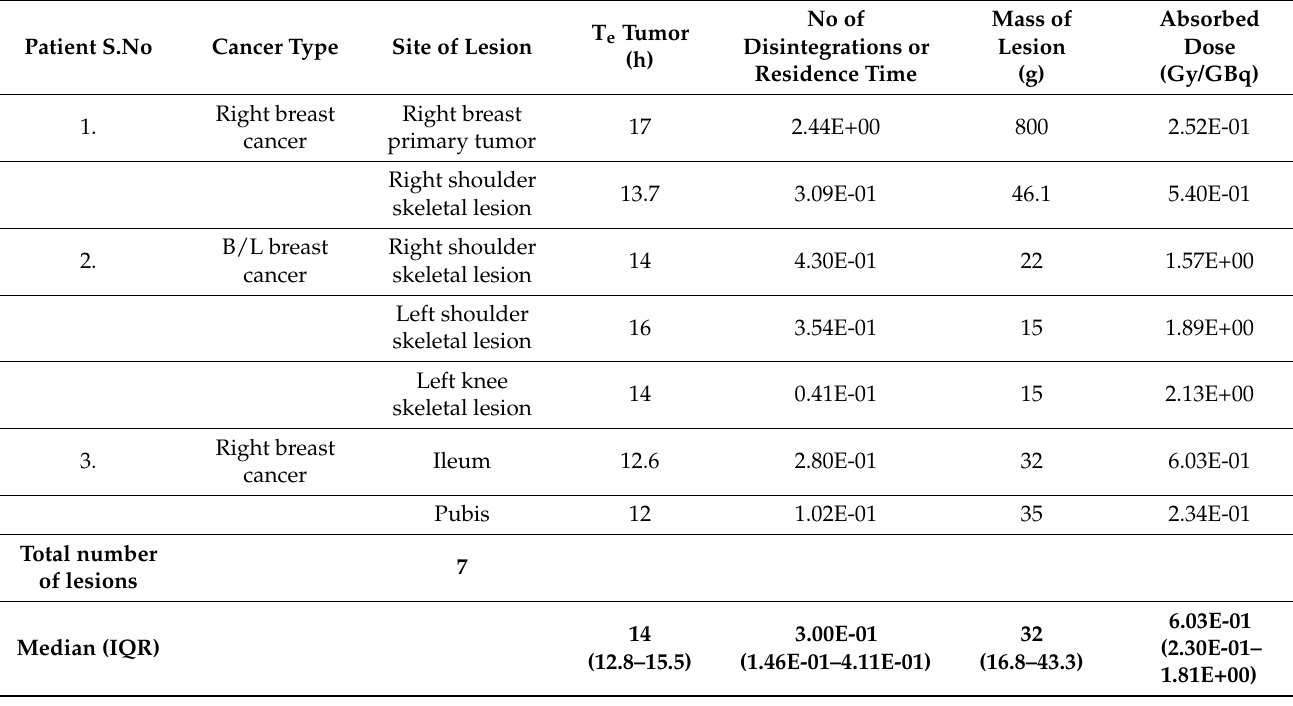
Table 5. Effective half-life (T e ) and dosimetry estimate of tumor lesions with [ 177 Lu]Lu-DOTA.SA.FAPi.